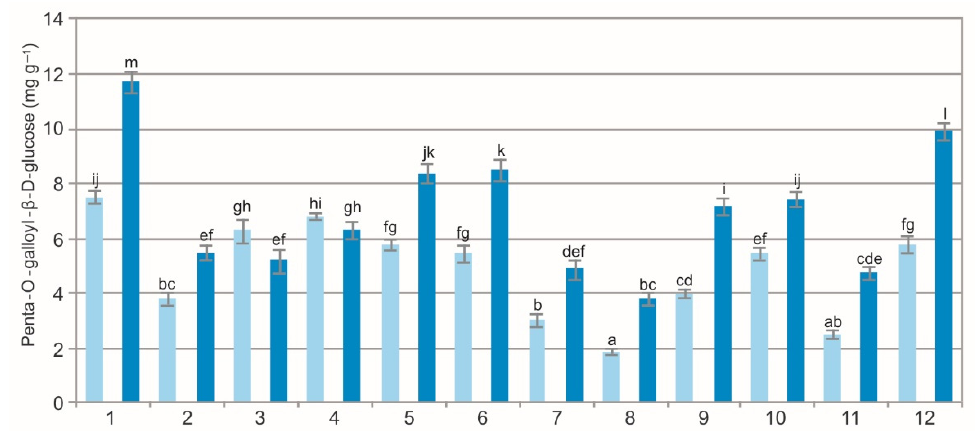
Figure 6. Penta-O-galloyl- β -d-glucose concentration in water (light blue) and ethanol (dark blue) leaf extracts from bearberry plants in different populations. The values designated by the different letters are significantly different ( p < 0.05).